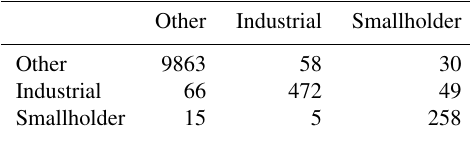
Table A3. Confusion matrix of the global oil palm layer (second half of 2019) validated with 10816 points. Columns represent the mapped classes, and rows are the true label.